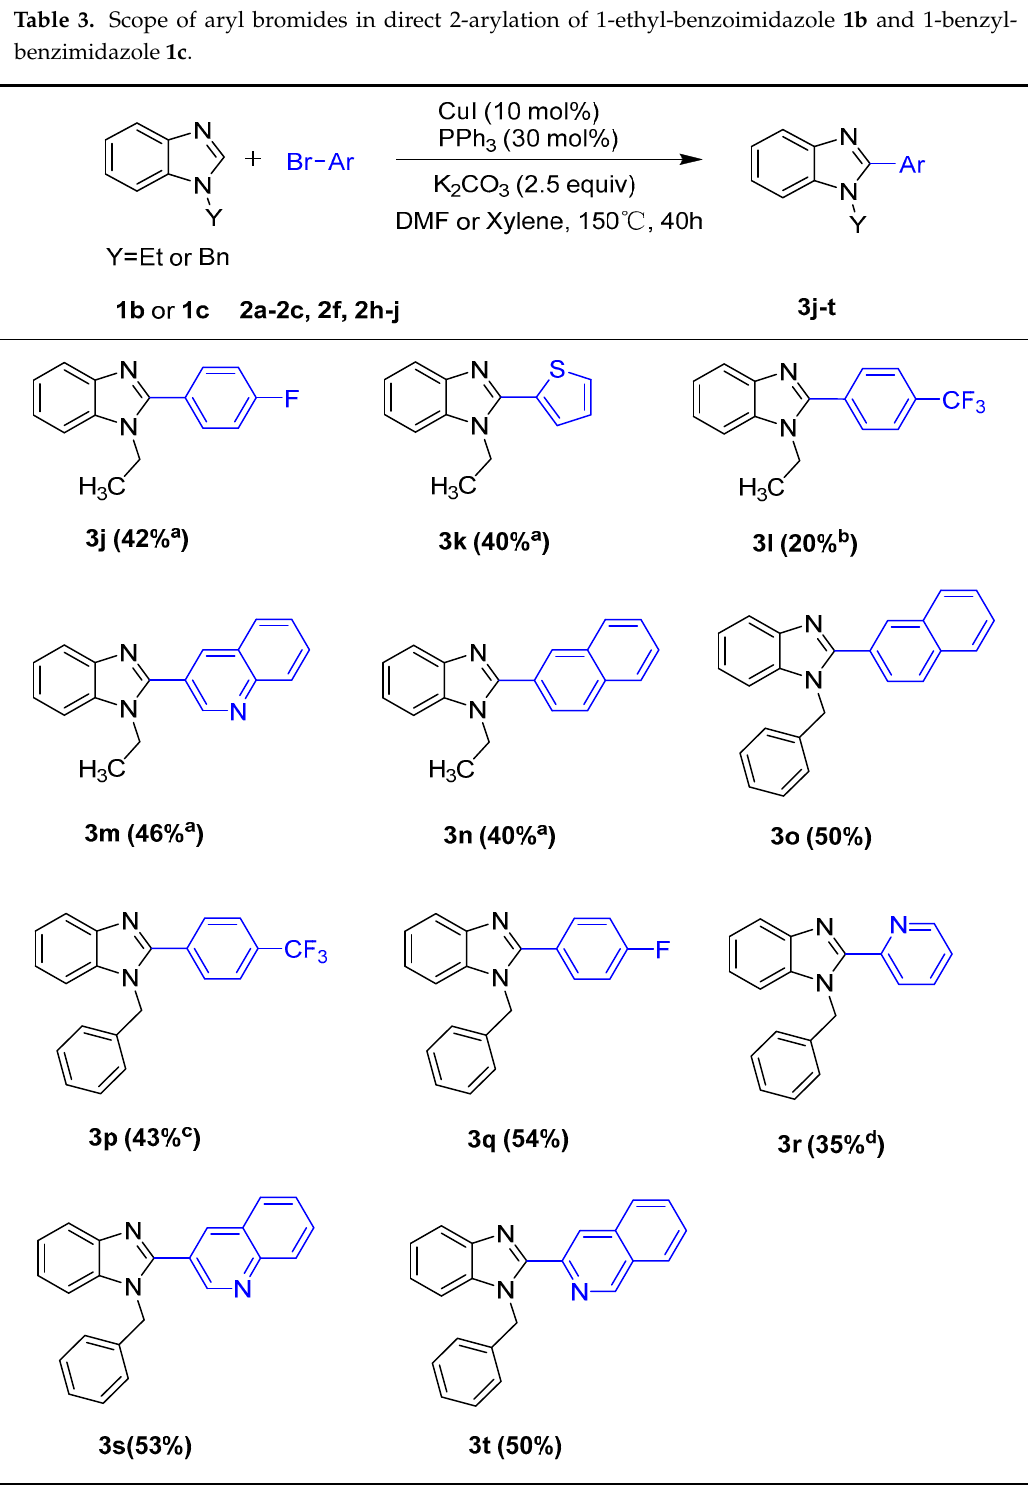
Table 3. Scope of aryl bromides in direct 2-arylation of 1-ethyl-benzoimidazole 1b and 1-benzyl- benzimidazole 1c .